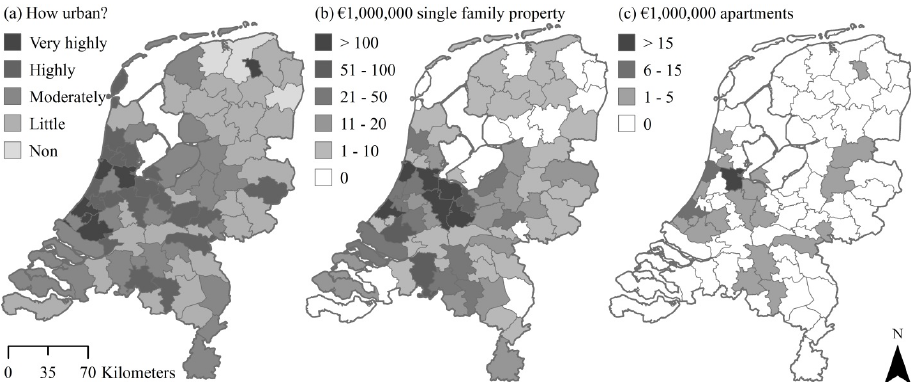
Figure 1. Urban density and million Euro transactions of single family properties ( N = 2303) and apartments ( N = 201), per local property market; ( a ) How urban; ( b ) € 1,000,000 single family property; ( c ) € 1,000,000 apartments.